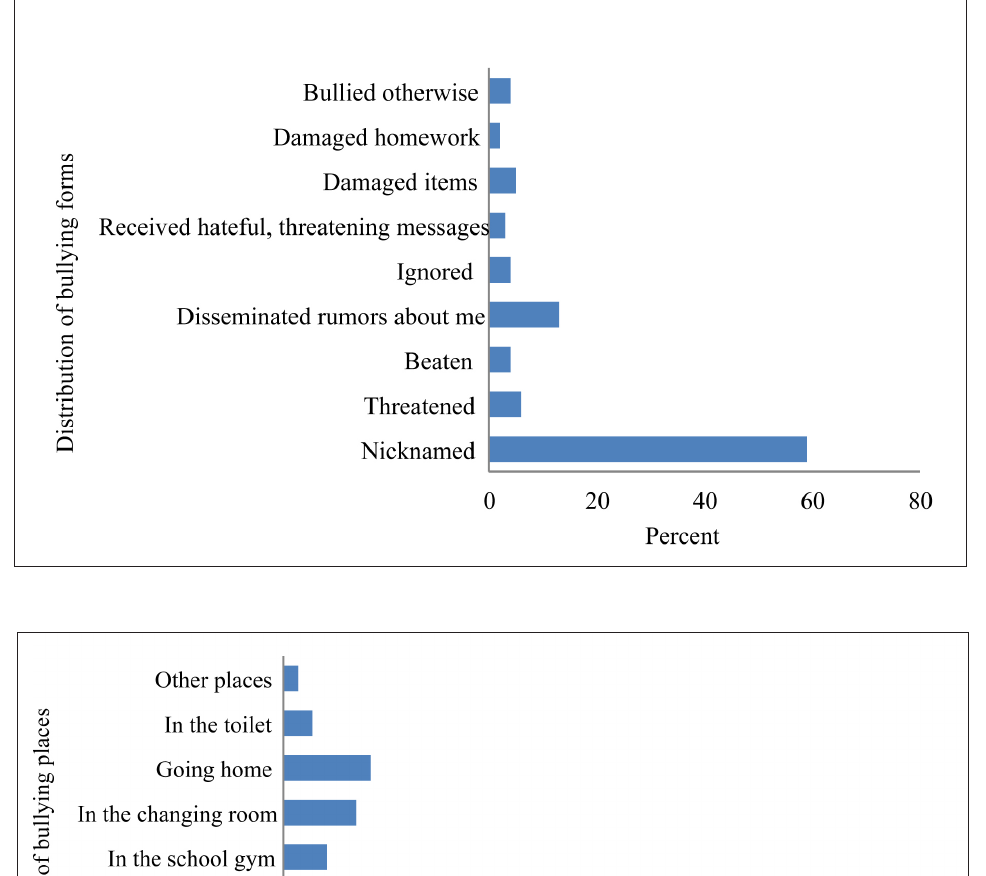
Figure 1. Percentage distribution of re-